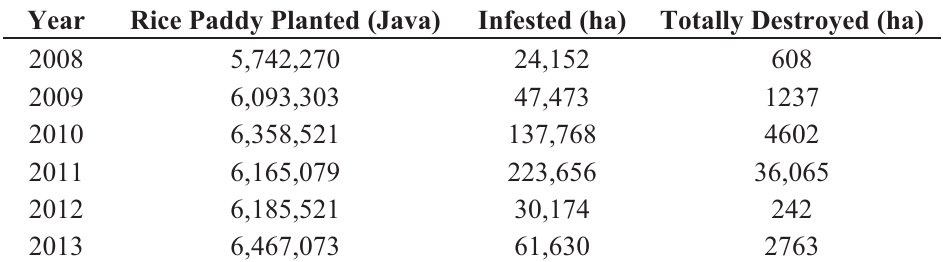
Table 2. Rice brown planthopper (BPH) Infestation 2008 – 2013. Year Rice Paddy Planted (Java) Infested (ha) Totally Destroyed